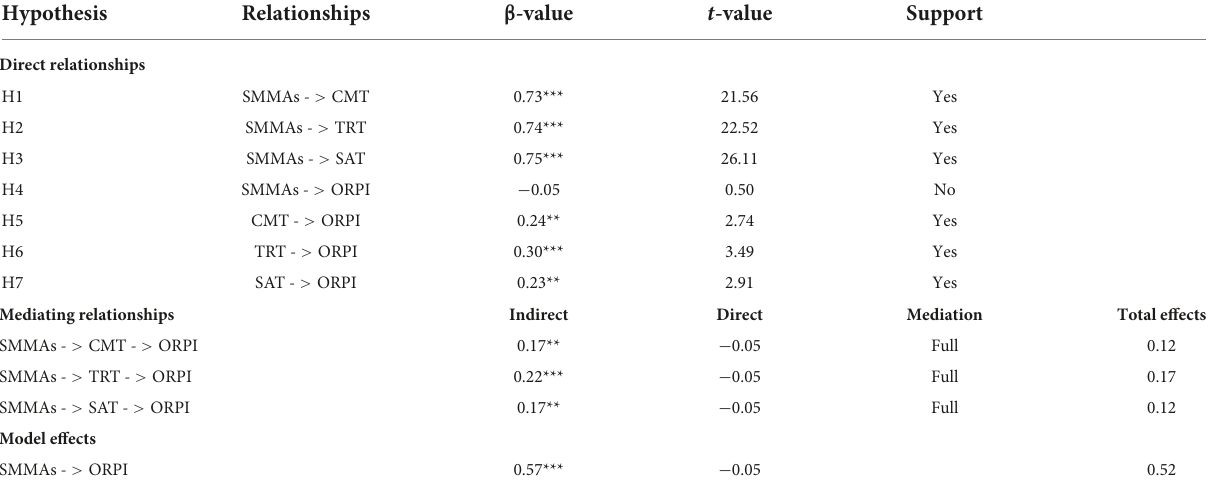
TABLE 4 Hypotheses testing